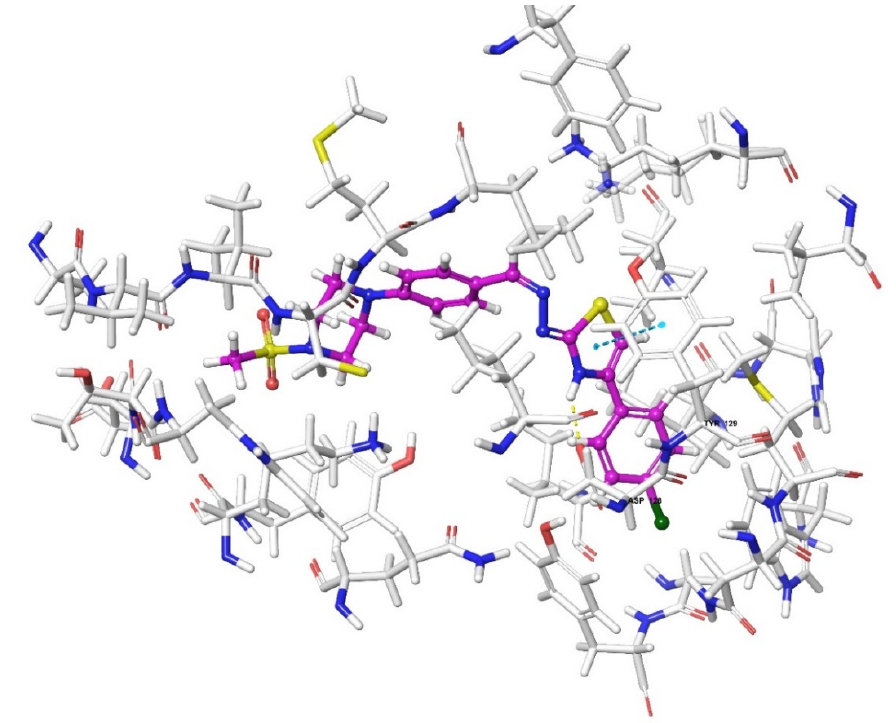
Figure 19. The three-dimensional interacting mode of compound 3g in the active region of δ -opioid receptor. The ligand and significant residues of the active site of the receptor are presented by a tube model colored with purple and white, respectively (PDB Code: 4N6H).